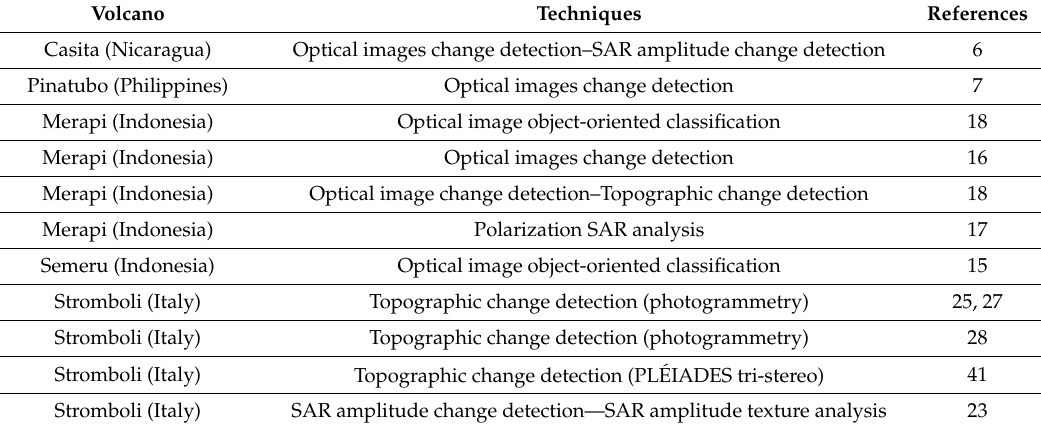
Table 2. Previous remote sensing-based studies on the geomorphological response to volcanic eruptions. Volcano